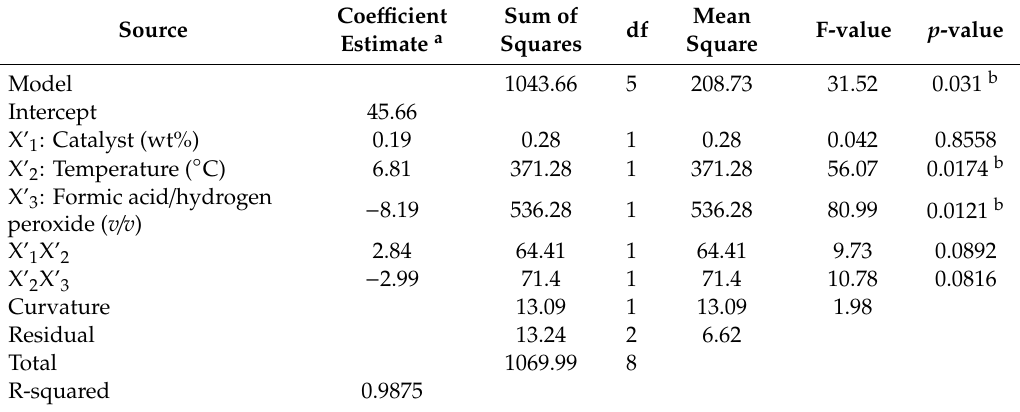
Table 4. ANOVA of the UFAME epoxidation